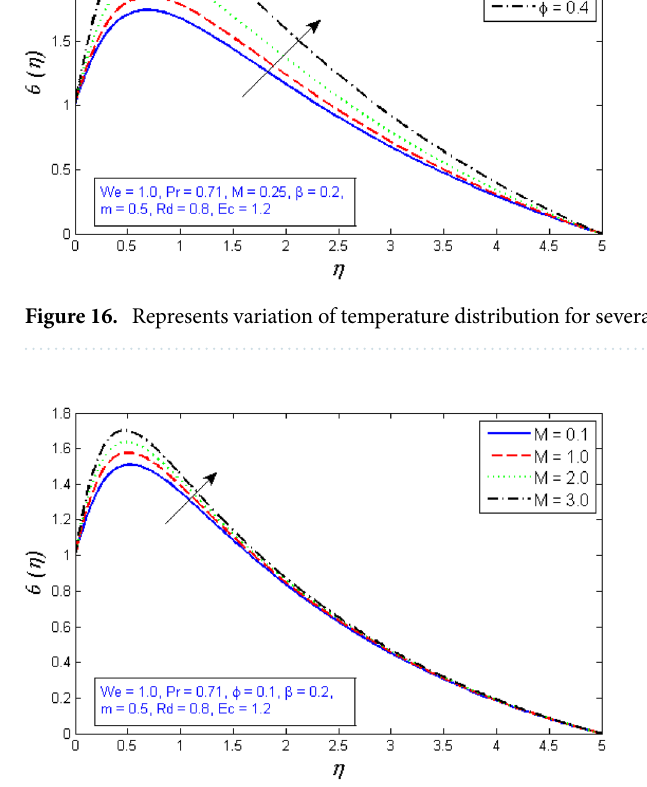
Figure 17. Variation of temperature distribution for several number of magnetic parameter M .